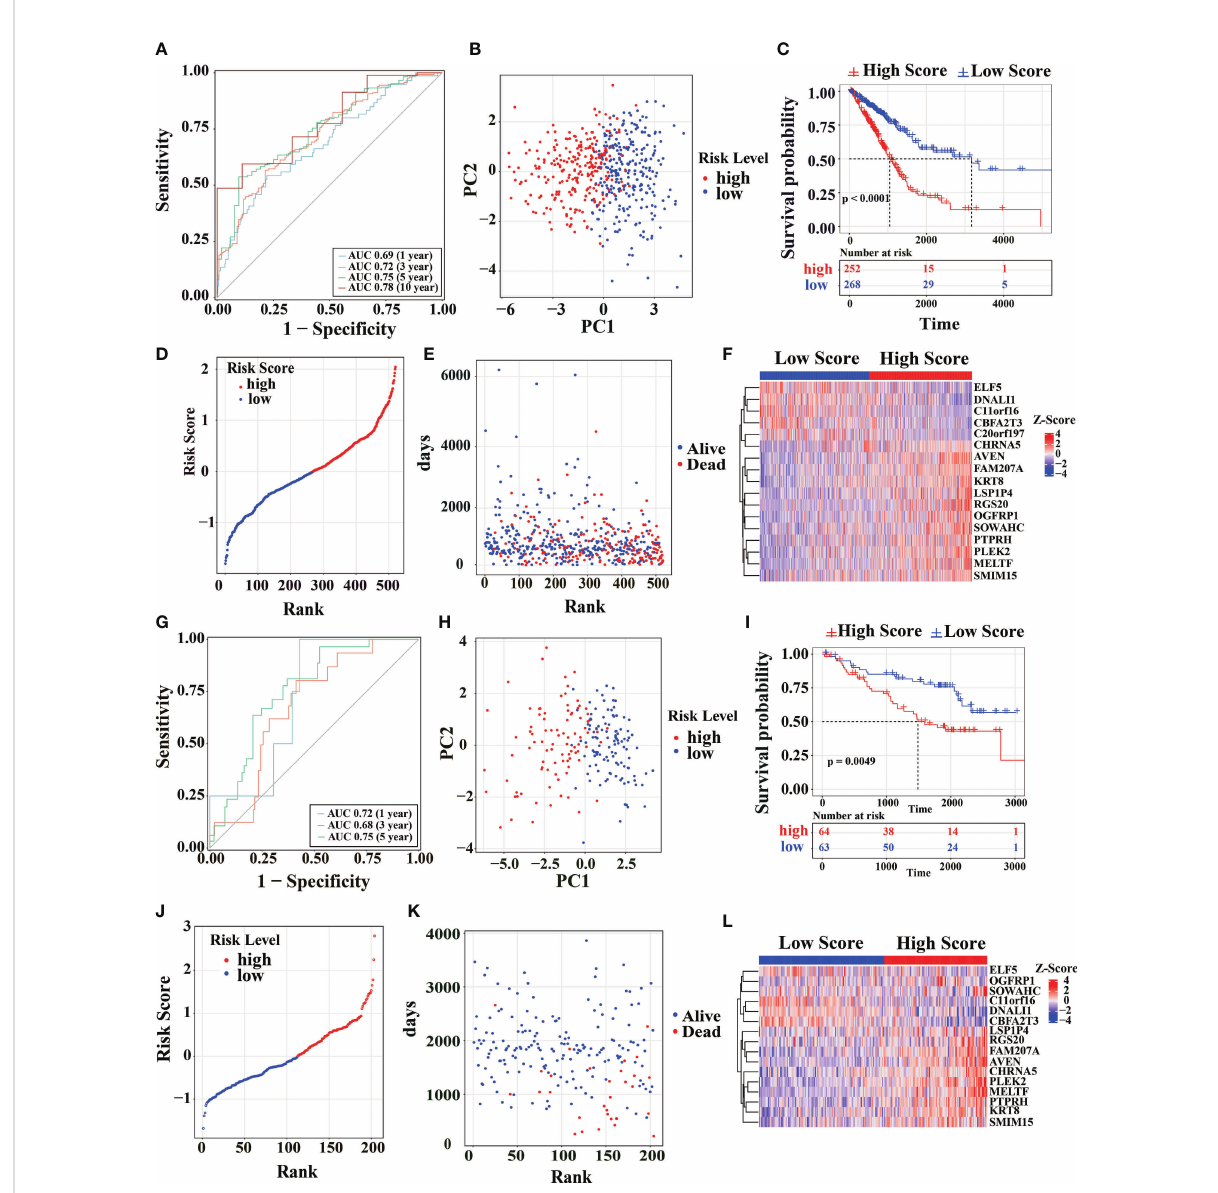
FIGURE 2 Survival analysis of the model in TCGA cohort. (A) Using TCGA-LUAD primary cancer samples and corresponding clinical records (n = 520) to calculate the AUC of time-dependent ROC curves of the risk score at 1, 3, 5 and 10 years. (B) PCA analysis was performed using the genes in Figure 1C of the primary LUAD sample in TCGA cohort. (C) The survival rates of LUAD patients were tested to test by KM survival analysis in the TCGA database. (D) Distribution map of different survival risks of LUAD patients in TCGA database. (E) Time distribution of LUAD patients with different survival risks and death in TCGA database (ordinate: follow-up time, abscissa: risk ranking). (F) Gene expression trends in Figure 1C of LUAD patients in TCGA database (top note: blue: low-risk, red: high-risk; Heat map below: Red: high expression, blue: low expression). (G-L) Patients from the GEO cohort (GSE31210) were analyzed similarly to the above analysis in TCGA